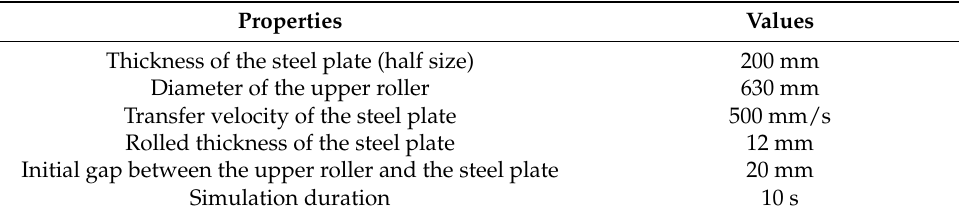
Table 1. Properties of stress analysis simulation.